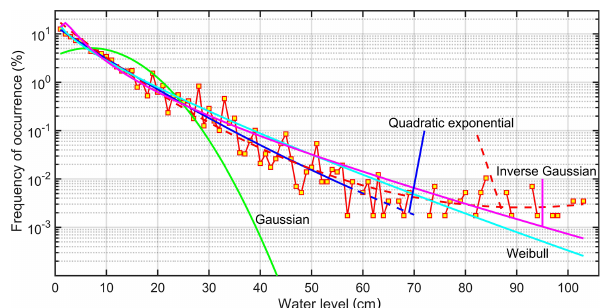
Figure 8. Simulated distributions of various set-up heights (red squares) with a resolution of 1cm in the westernmost coastal seg- ment of the study area (grid point 1 in Fig. 2) and the relevant Gaussian (mean 6.811cm, standard deviation 7.83cm), Weibull (shape parameter 0.8342, location parameter 6.22cm), and in- verse Gaussian (Wald, shape parameter 5.154, scale parameter or mean 6.811cm) distributions evaluated using the method of mo- ments. Blue line: interpolation of the empirical distribution in semi- logarithmic coordinates with a quadratic function (equivalently, the formal local exponential distribution with a general quadratic expo- nent) from the set-up height of 0.01m to the first gap in the empiri- cal distribution ( a = 0 . 0004, b = − 0 . 16, c = 2 . 66); red dashed line: similar interpolation using all data points ( a = 0.0011, b = − 0 . 20, c = 3 .